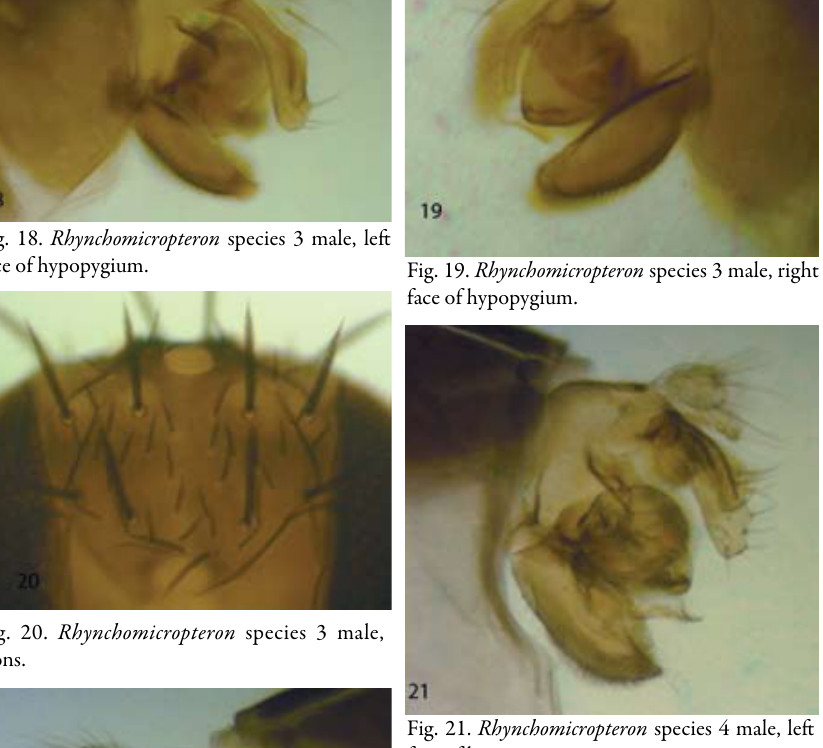
Fig. 21. Rhynchomicropteron species 4 male, left face of hypopygium.